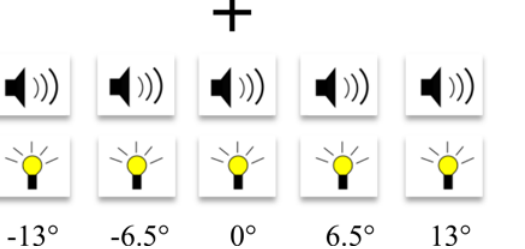
Fig 2. The spatial localization paradigm. Stimuli could be presented from one of five locations, ranging from -13 to +13